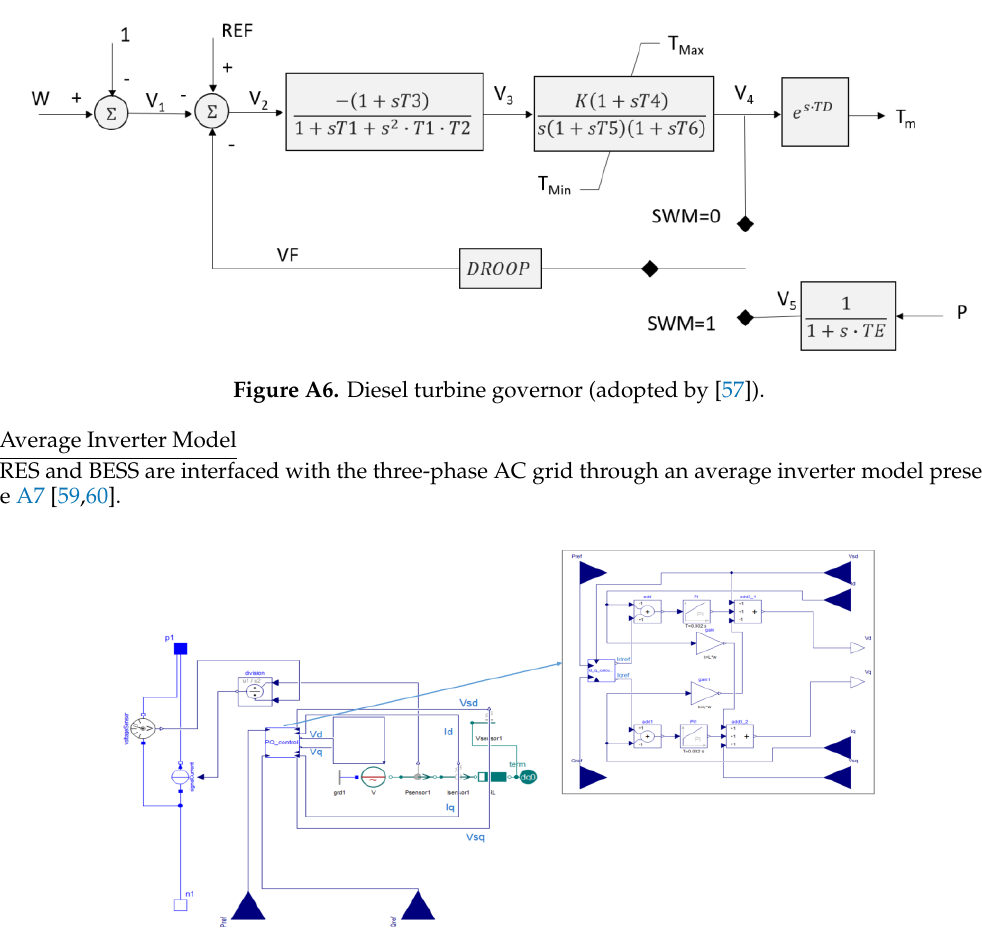
Figure A7. Modelica’s average inverter model.